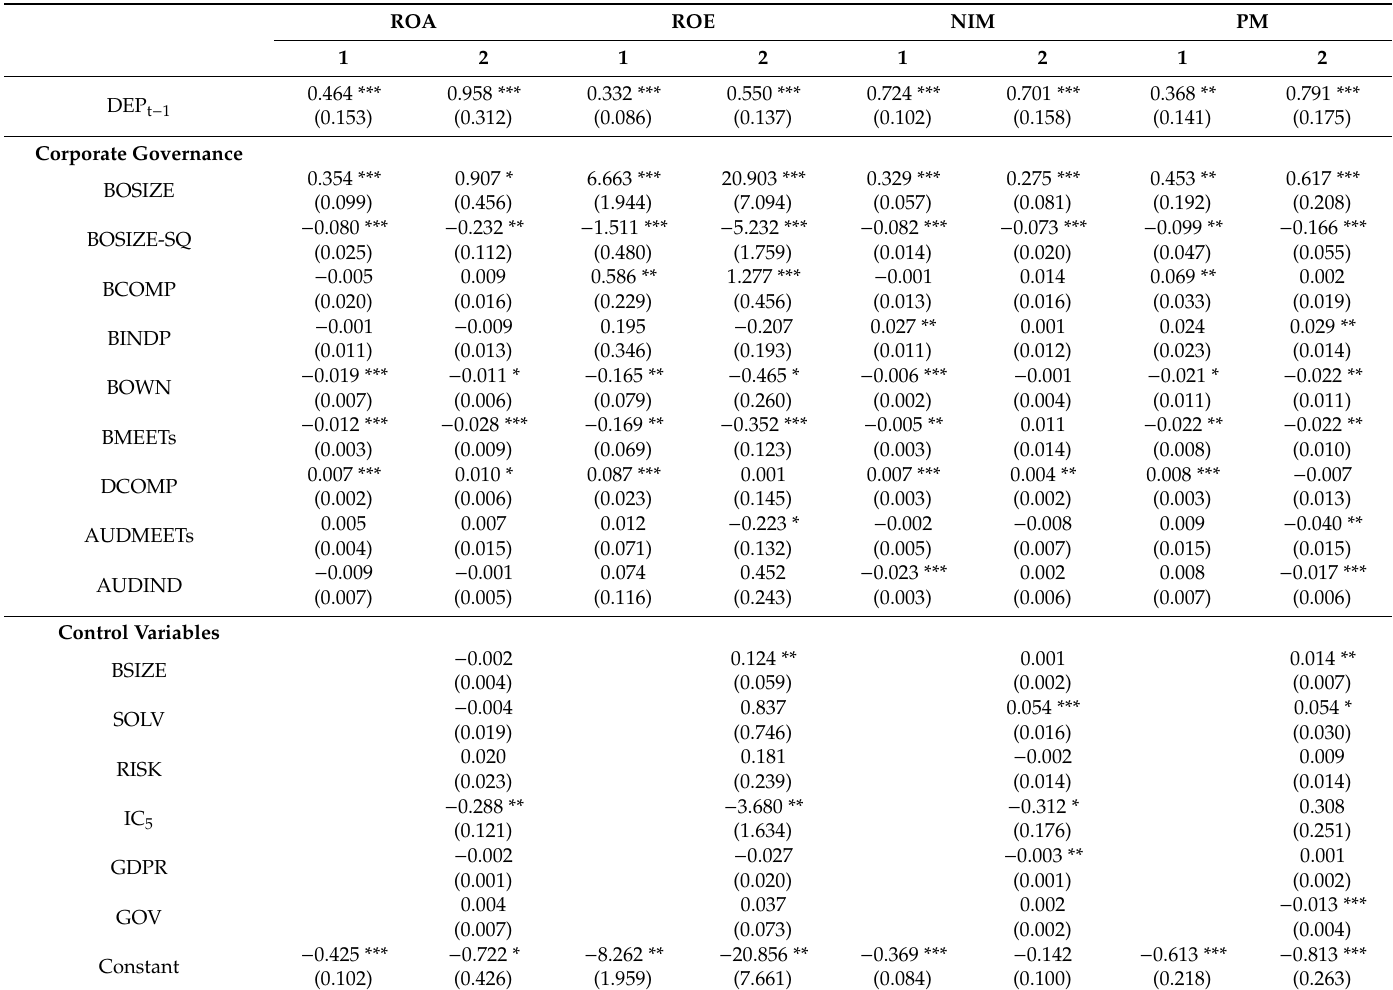
Table 7. Corporate governance characteristics and banks